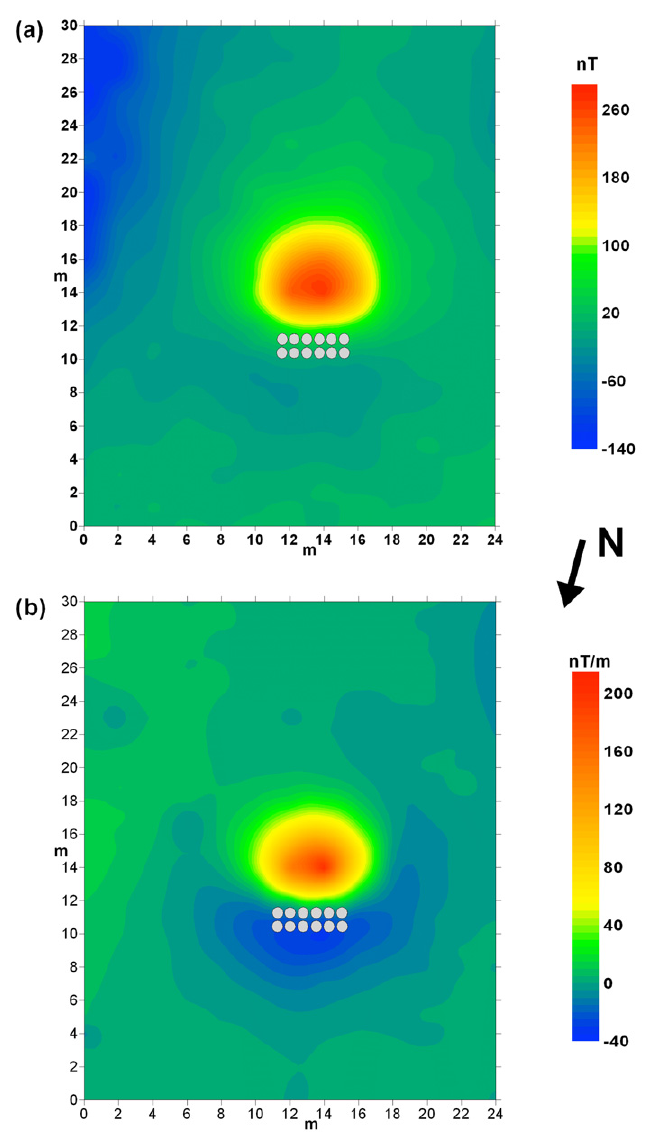
Figure 2. The test site with 12 buried drums. The magnetic inclination was around 58º. (a) Anomaly map of the total intensity field. (b) Map of the vertical